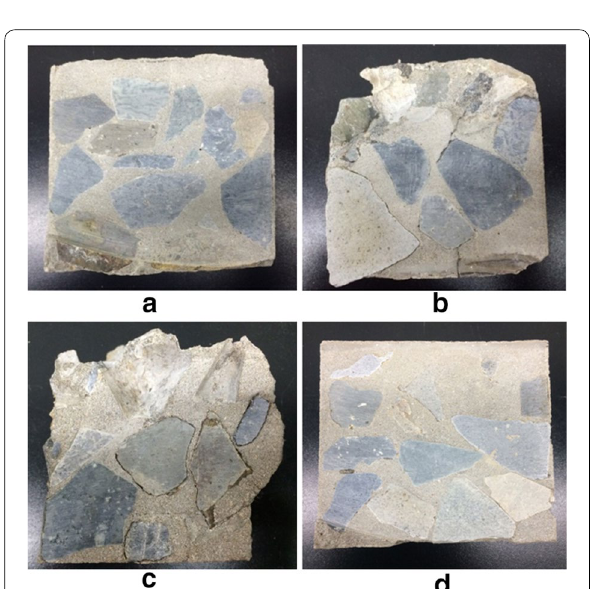
Fig. 22 Specimen sections with L-level aggregates after